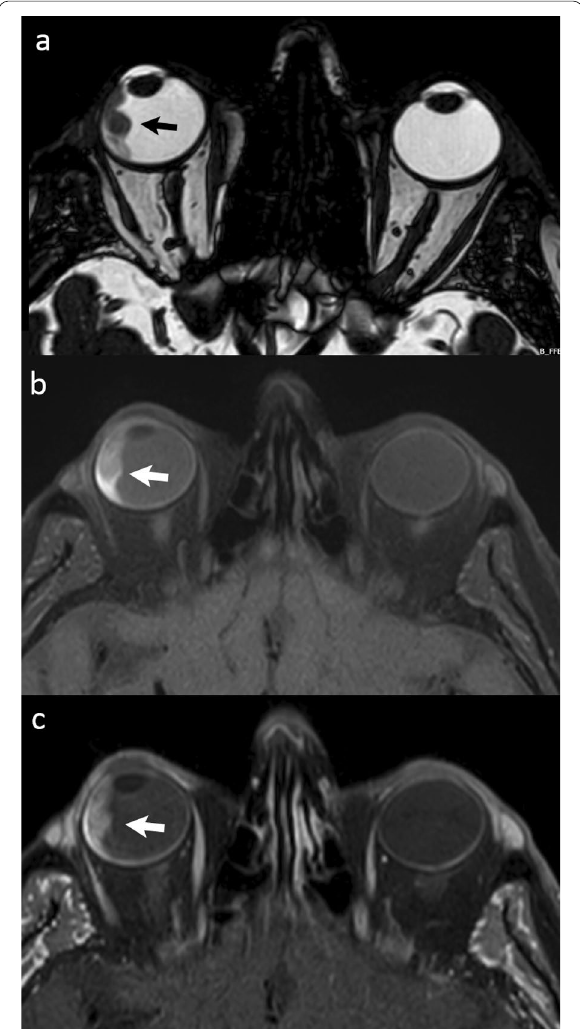
Fig. 5 Axial balanced fast field echo (bFFE) MR image ( a ) showing an irregular and hypointense tissue plaque along the lateral wall of the right eye. Nonenhanced turbo spin echo (TSE) after spectral presaturation with inversion recovery (SPIR) T1-w. scan b demonstrates that the lesion is hyperintense. On contrast-enhanced TSE T1-w. image (obtained after subtraction of signal of nonenhanced image) ( c ) enhancement of the lesion can be seen, demonstrating that the lesion is vascularized. The findings are consistent with melanoma